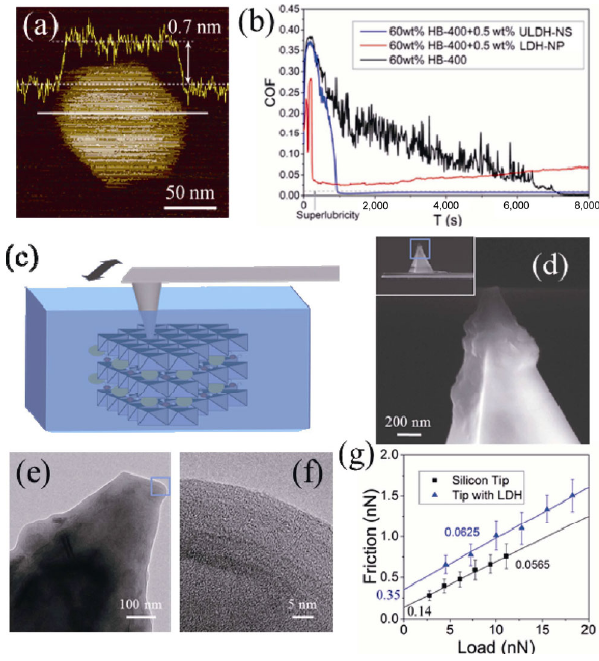
Fig. 11 (a) AFM image and cross-sectional profile of ULDH–NS. (b) COF of 60 wt% PAG aqueous solution and those with two 0.5 wt% LDH additives: ULDH–NS and LDH–NP. (c) Schematic illustration of AFM friction test in water. (d) SEM image, (e) TEM image, and (f) HRTEM image of AFM tip with ULDH–NS. (g) Friction obtained between silicon tip vs. mica, and tip with LDH vs . mica. Reproduced with permission from Ref. [74], © American Chemical Society